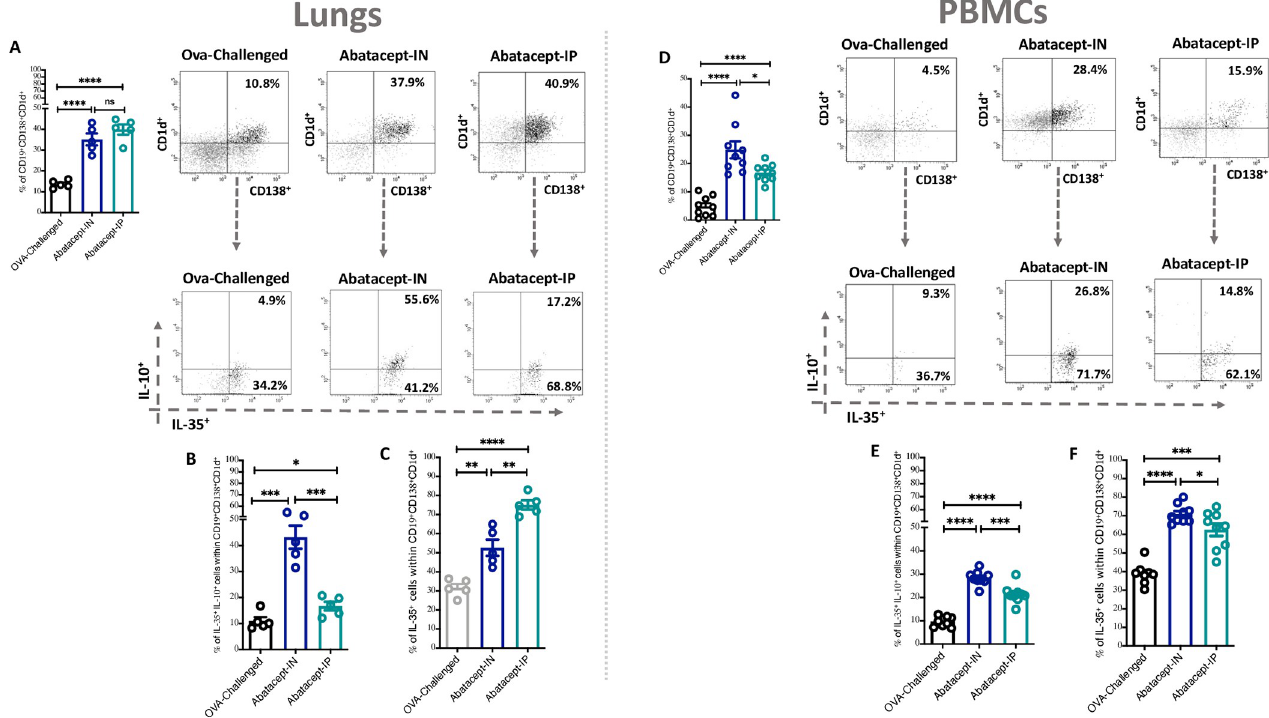
Fig 3. Abatacept enhances the levels of IL-35 and IL-10 producing Bregs in lung tissues and peripheral blood of OVA- sensitized mice. (A) Percentage of CD19 + CD138 + CD1d + cells in the lung tissues of abatacept IN, abatacept IP treated, or OVA challenged mice. (B-C) Percentage of IL-35 + IL-10 + Bregs and IL- 35 + Bregs in the lung tissues of abatacept IN, abatacept IP treated, or OVA challenged mice. (D) Percentage of CD19 + CD138 + CD1d + cells in the PBMCs of abatacept IN, abatacept IP treated, or OVA challenged mice. (E-F) Percentage of IL-35 + IL-10 + Bregs and IL-35 + Bregs in the PBMCs of abatacept IN, abatacept IP treated, or OVA challenged mice. Lung tissues of 5 mice and PBMCs of 10 mice were used. Two-way unpaired t-test was used to calculate significance. � ��� P < 0.001. Events were recorded and analysed by using BD FACSDiva version 8.0.